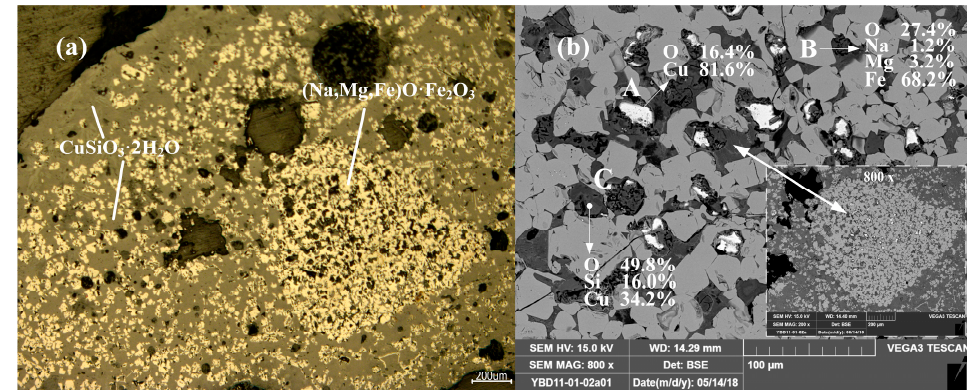
Figure 15. Optical micrograph ( a ) and SEM backsca tt ered electron image ( b ) of YBD11. Sample YBD12: The copper ore in the sample were mainly needle-like crystals of Cu 2 O·Fe 2 O 3 (delafossite) and large particles of Cu 2 O (cuprite), with traces of oxidized ga- lena. No metallic copper particles were detected under examination using optical micros- copy. As shown in Figure 16. Figure 16. Optical micrograph ( a ) and SEM backsca tt ered electron image ( b ) of YBD12. Sample YBD23: The main phases present in the slag were Fe 3 O 4 (magnetite) crystals, which were densely distributed between columnar grains of 2FeO·SiO 3 (fayalite). There were trace amounts of Cu 2 O (cuprite) present. No metallic copper particles were detected under examination using optical microscopy. As shown in Figure 17.